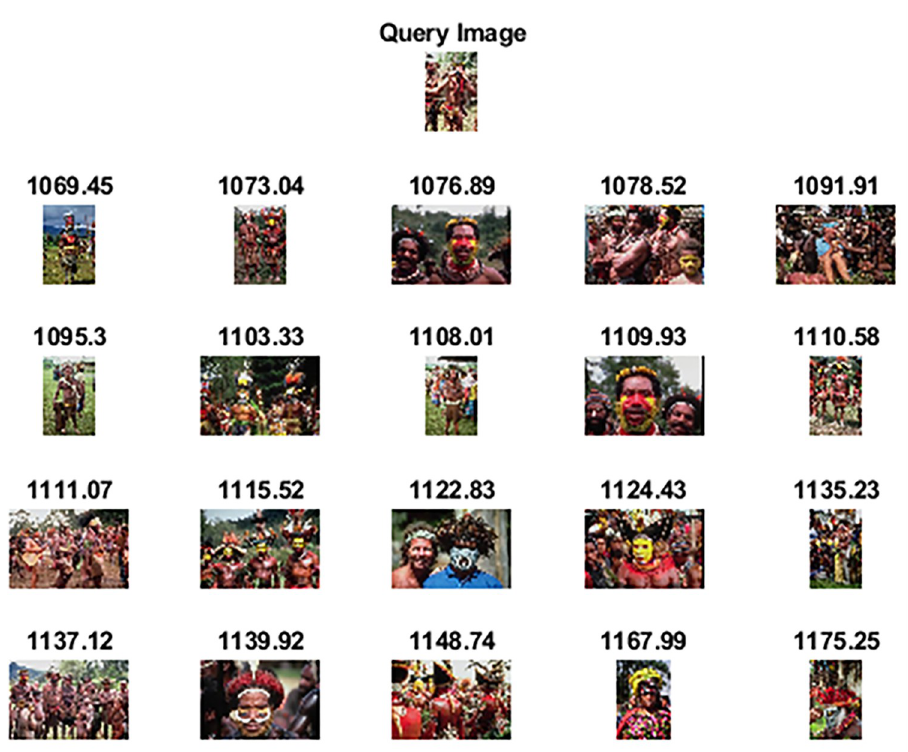
Fig 7. Top-20 retrieved images against query image (class: African tribes) (reprinted from [3] under a CC BY license, with permission from J. Z. WANG, original copyright [2003]).